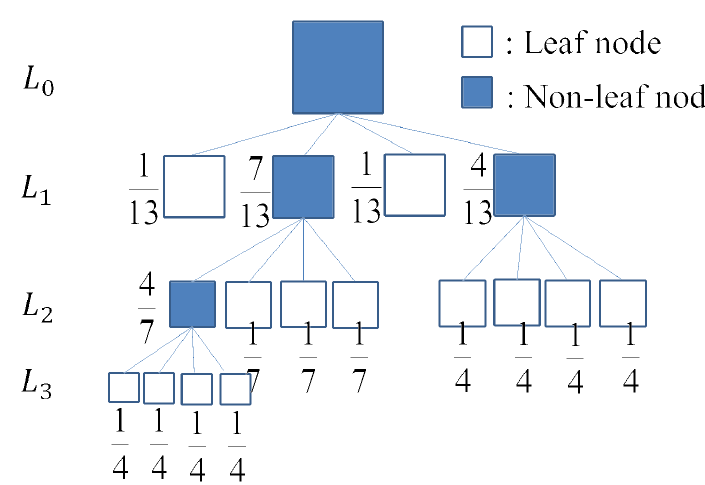
Figure 6. An example of a quad-tree